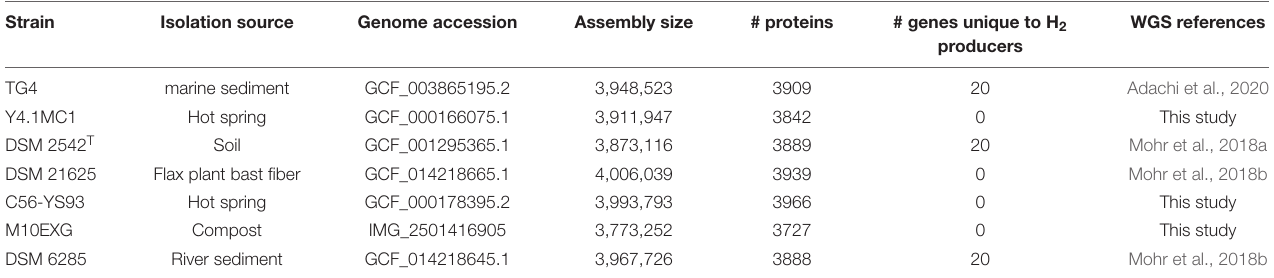
TABLE 1 | Features of Parageobacillus thermoglucosidasius strains included in this